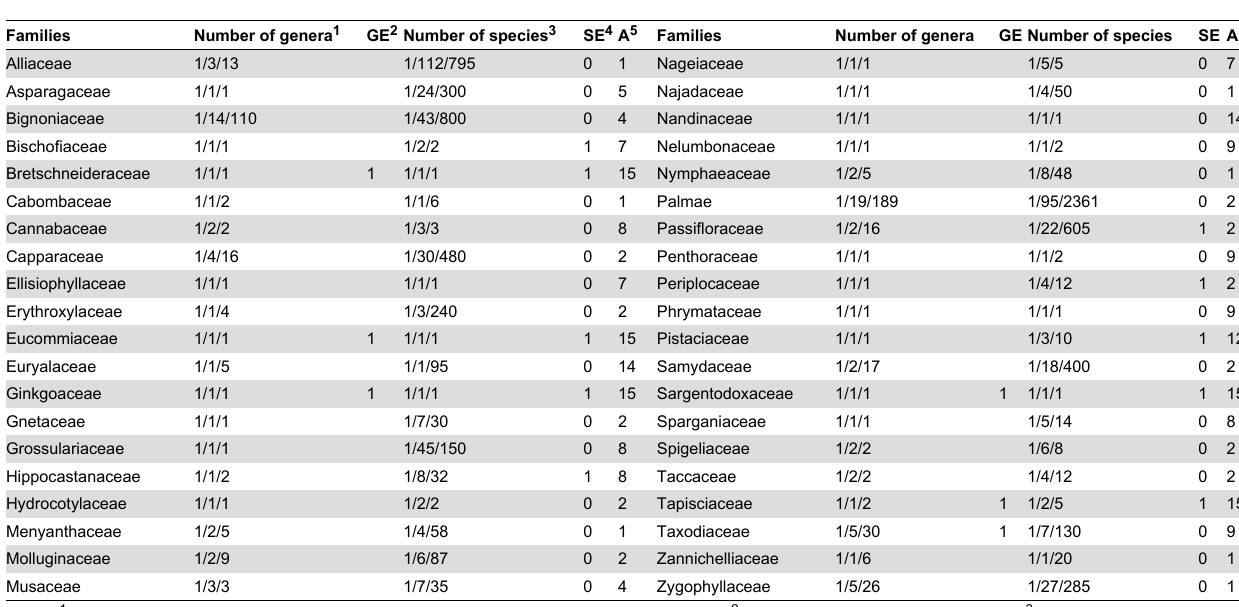
Table 6. Ranking of families (with 1 species) in Mount Jinggangshan region based on numbers of genera and species.